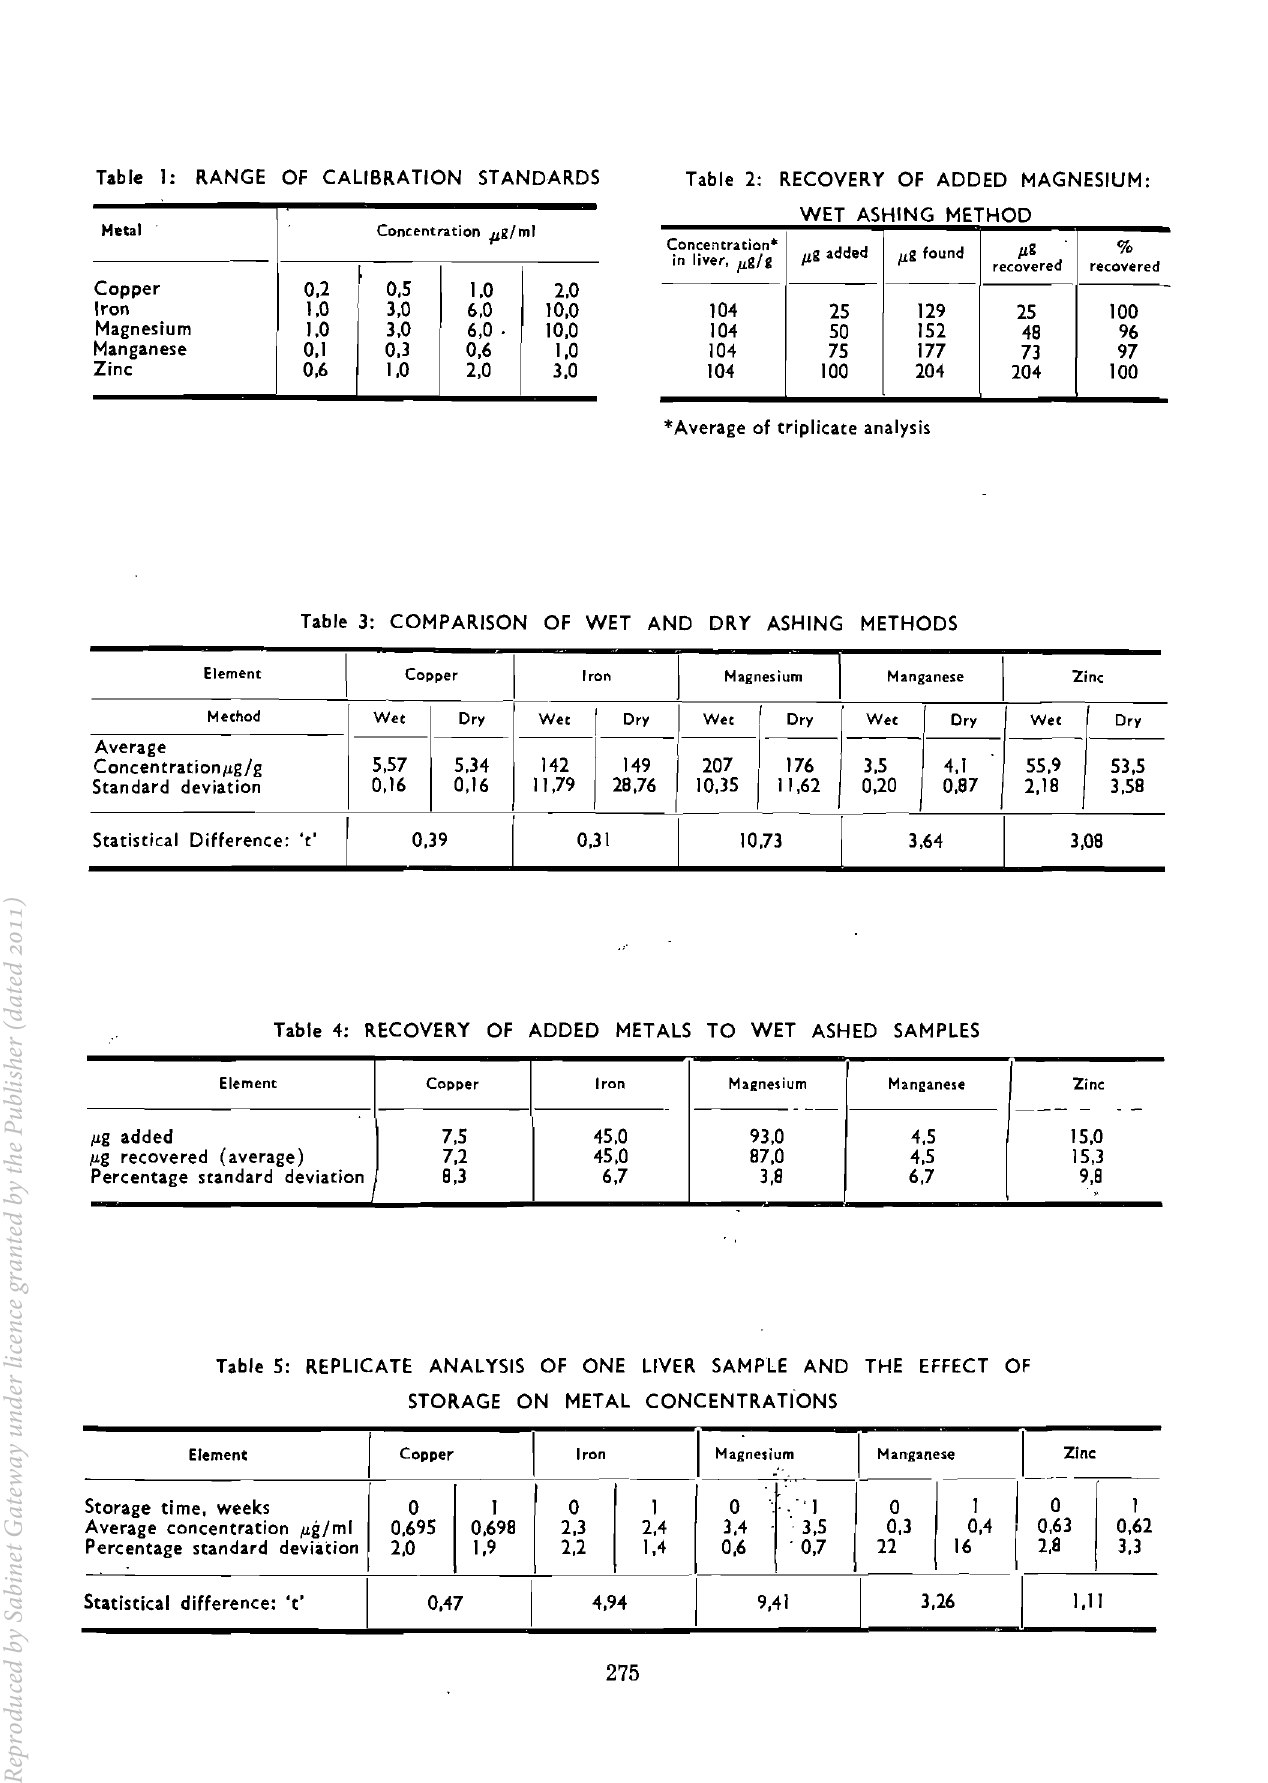
Table 5: REPLICATE ANALYSIS OF ONE LIVER SAMPLE AND THE EFFECT OF STORAGE ON METAL CONCENTRA